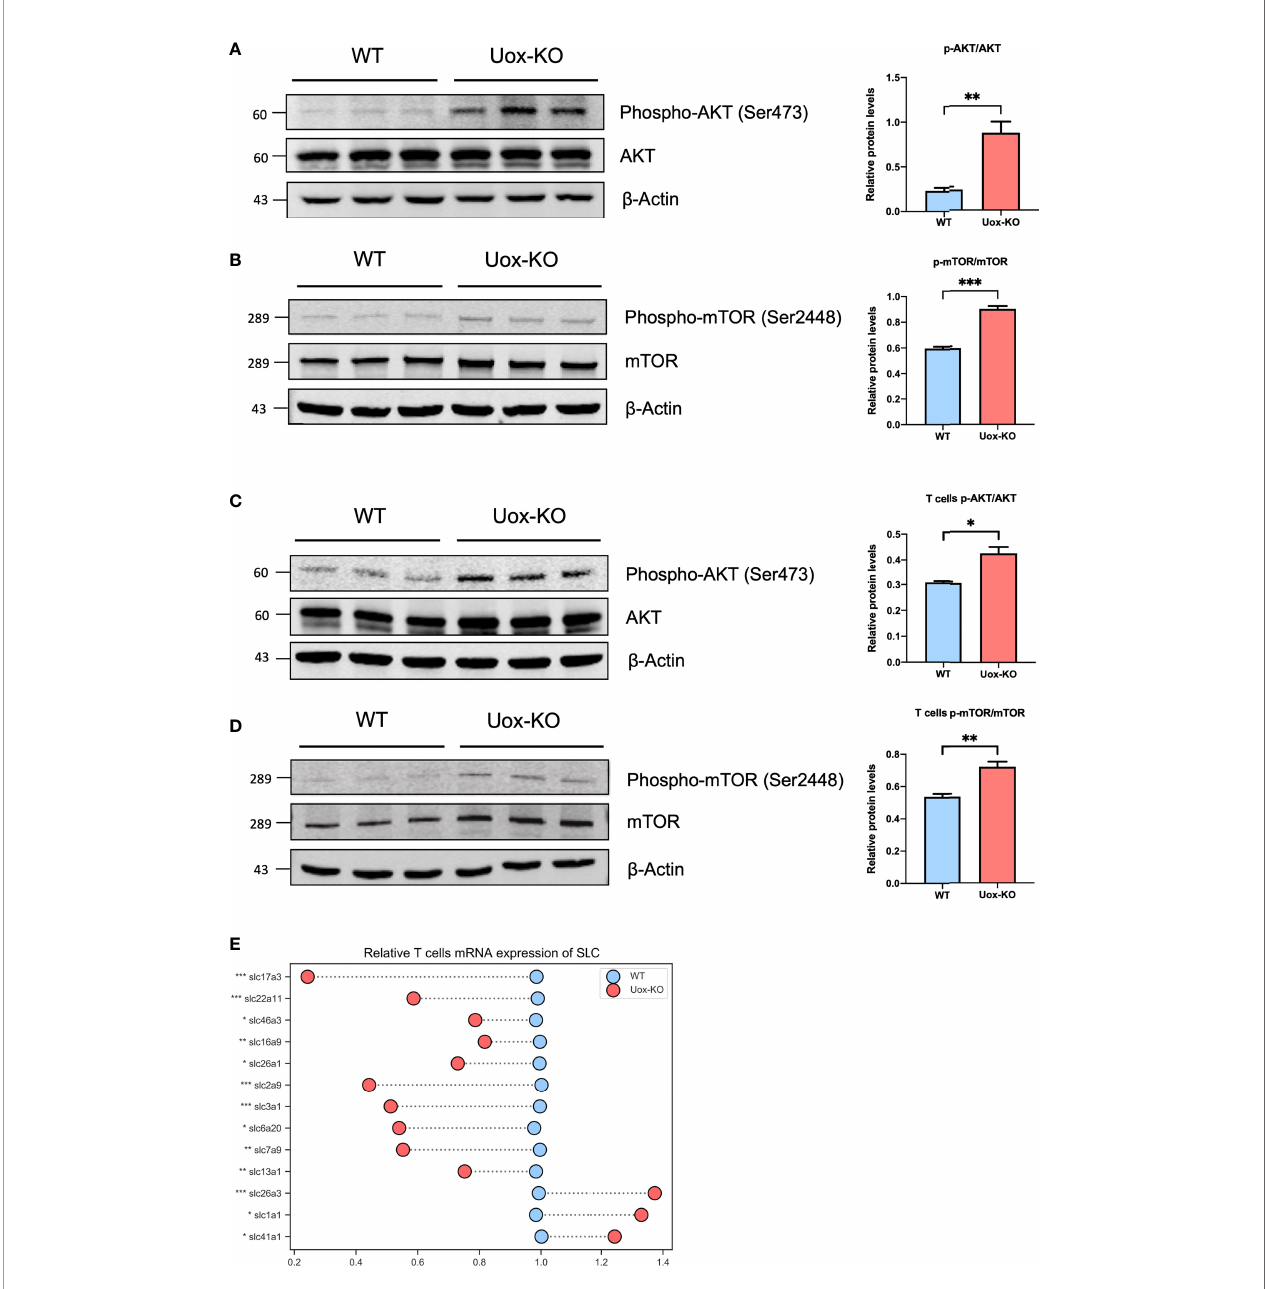
FIGURE 5 | Activation of the Akt-mTOR pathway in intestine of Uox -KO mice. (A) The expression of total Akt and phosphorylation at the Ser473 residue in the colon were evaluated by Western blotting analysis. The gray value ratios of the phosphorylated Akt bands over the internal reference b -actin band were used to quantify the expression of phosphorylated Akt by Image J software. (B) The expression of total mTOR and phosphorylation at the Ser2448 residue in the colon were evaluated as stated above. (C) The expression of total Akt and phosphorylation at the Ser473 residue in the intestinal CD4 + T cells. (D) The expression of total mTOR and phosphorylation at the Ser2448 residue in the intestinal CD4 + T cells. (E) mRNA expression of SLC transporters in CD4 + T cells. Values are expressed as mean ± SEM (N = 3 mice/group). * p < 0.05; ** p < 0.01; *** p <